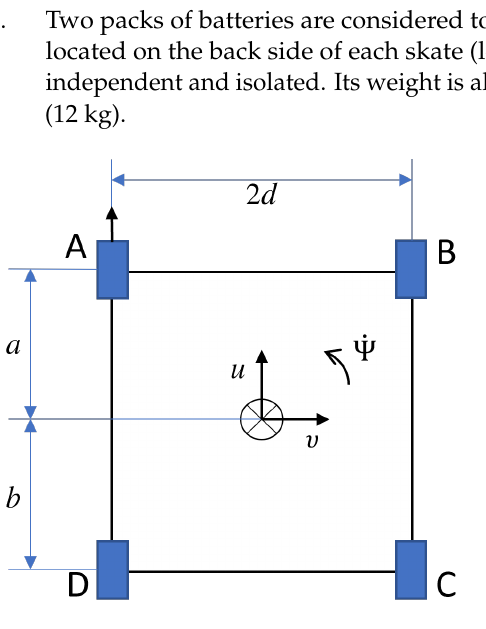
Figure 13. Free Body